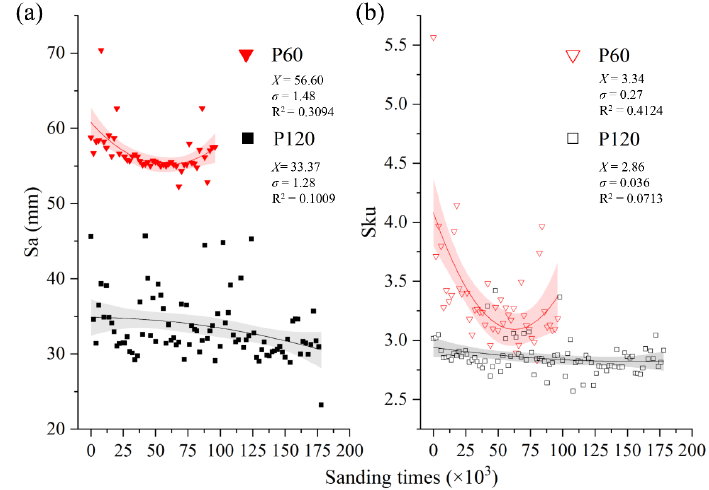
Figure 7. Surface roughness of abrasive belt during MDF sanding: ( a ) S a; ( b ) S ku. Where X means the average value of surface roughness, σ means the standard deviation of surface roughness, R 2 means the correlation coefficient of quadratic fitting.